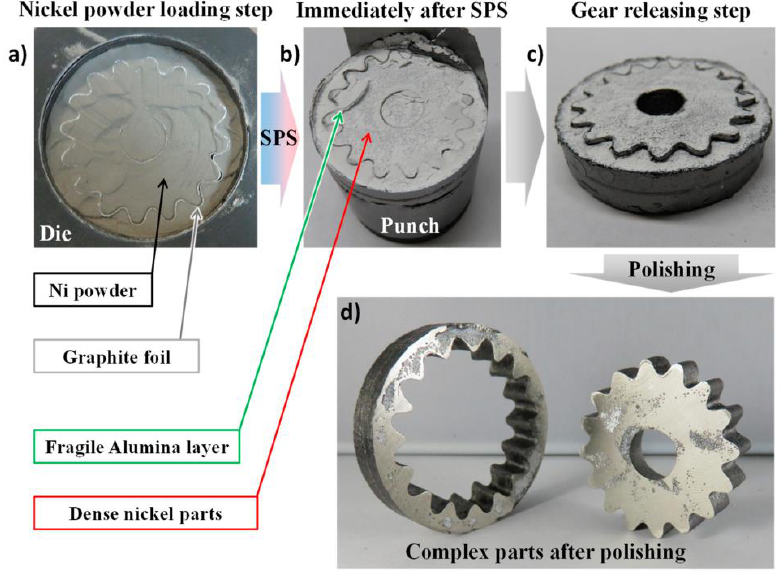
Figure 8. Controllable interface approach process steps for SPS densification of 40 mm nickel gears; where ( a ) shows loading; ( b ) following SPS; ( c ) gear releasing; and ( d ) polished parts. [66].